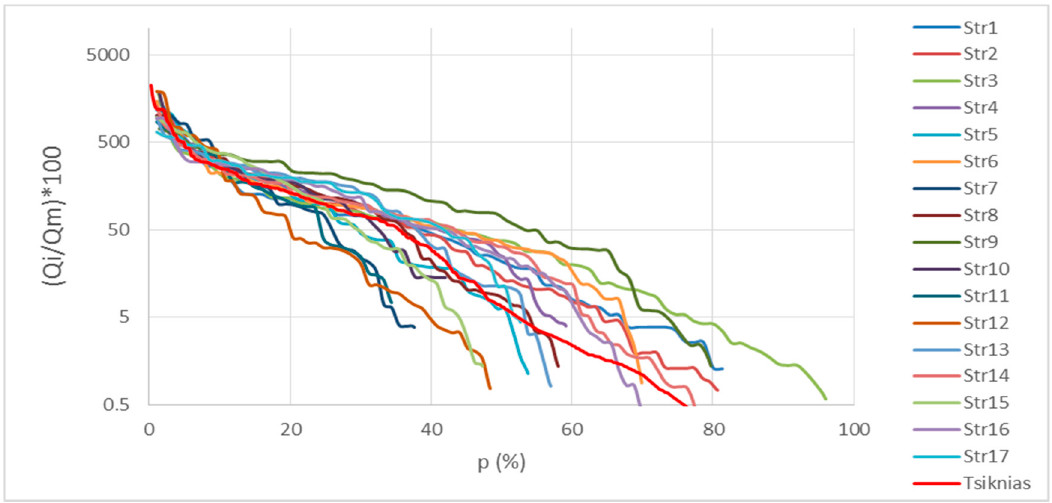
Figure 7. Flow duration curve of the intermittent-flow rivers of Crete.